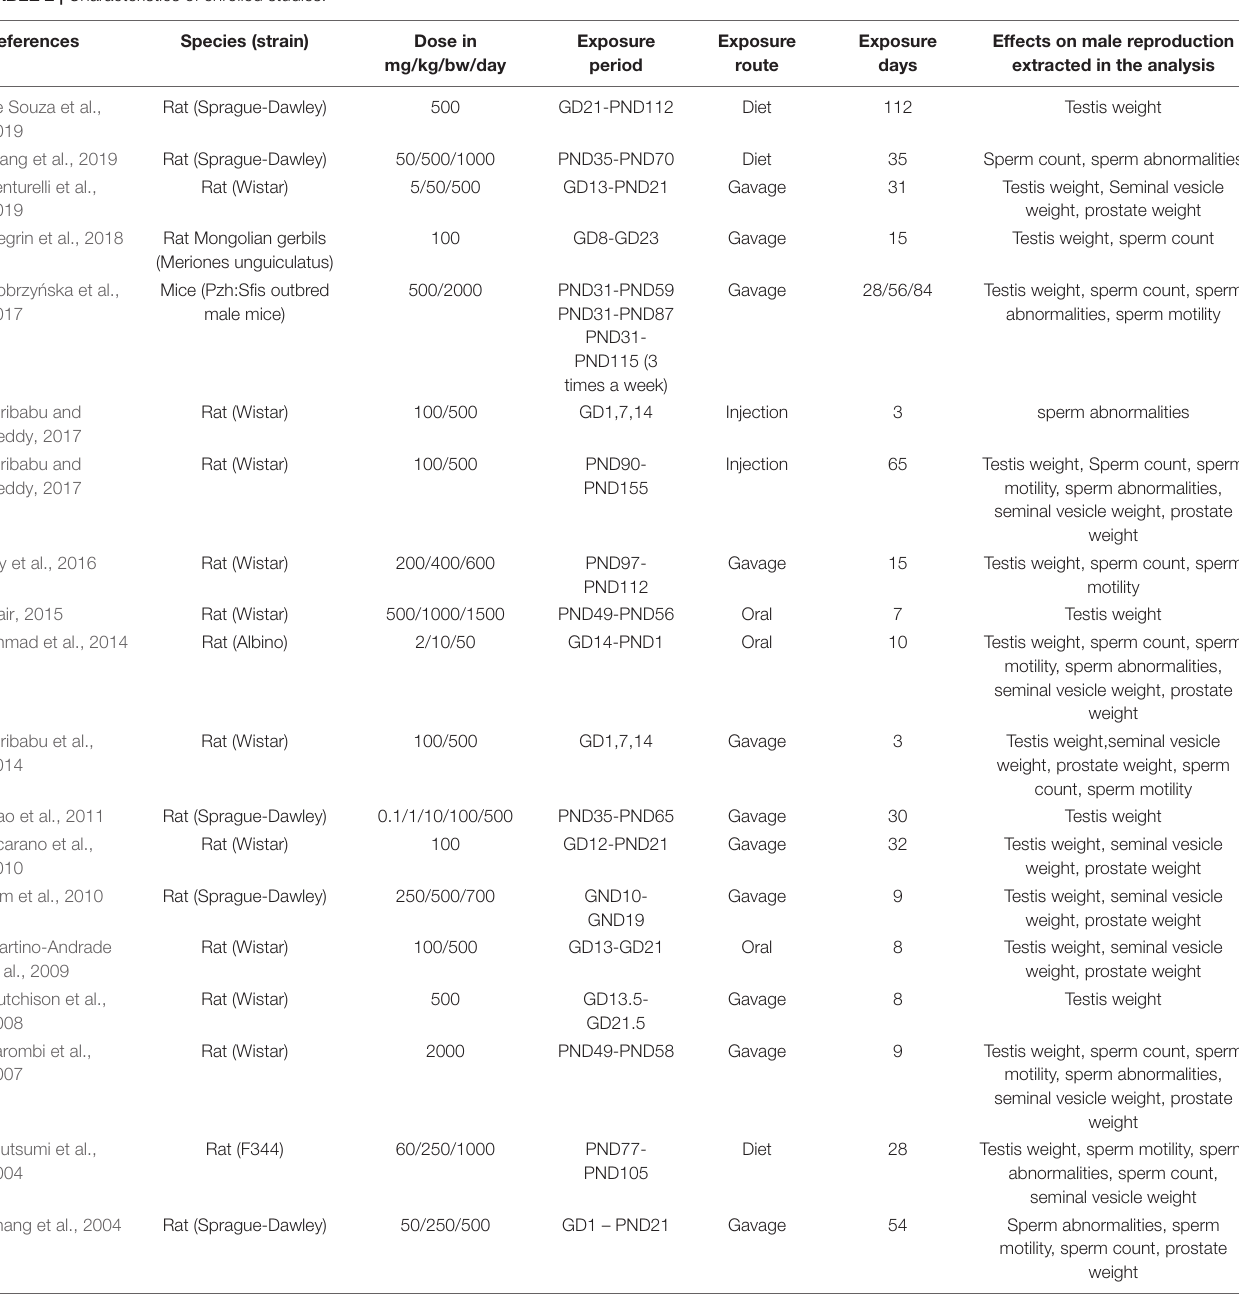
TABLE 2 | Characteristics of enrolled